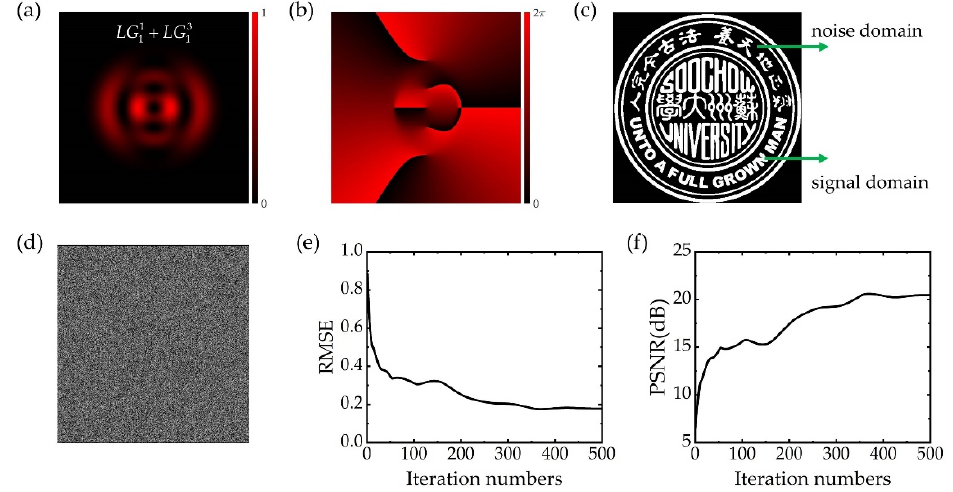
Figure 4. ( a ) The intensity and ( b ) phase distribution of the numerically simulated composite OAM beam; ( c ) target image containing signal and noise domain; ( d ) CGH of the target image ( c ); ( e ) RMSE; and ( f ) PSNR.